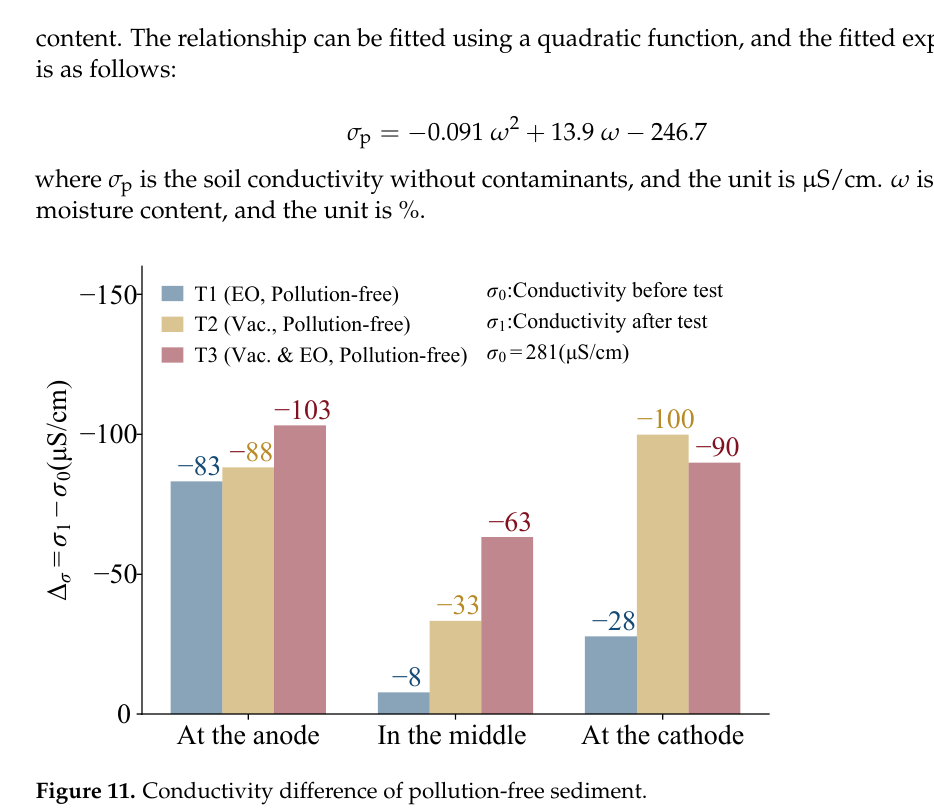
Figure 11. Conductivity difference of pollution-free sediment.